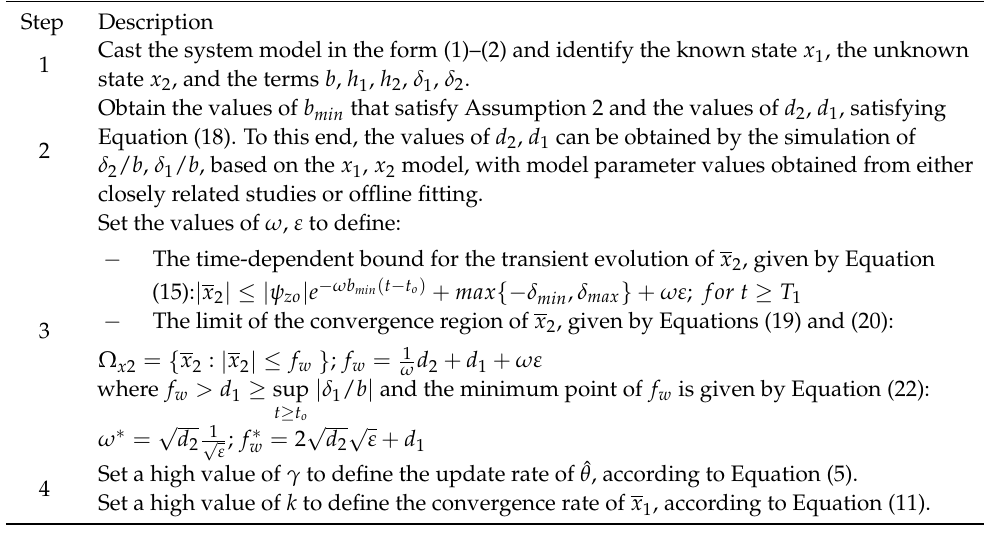
Algorithm 1: Algorithm for setting the parameters of the observer